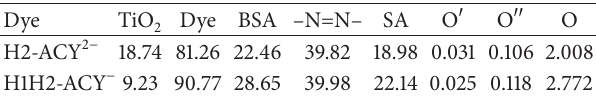
Table 7: Contributions of various groups, in %, to the electron density of the HOMO and LUMO, calculated at DFT/B3LYP/DZVP